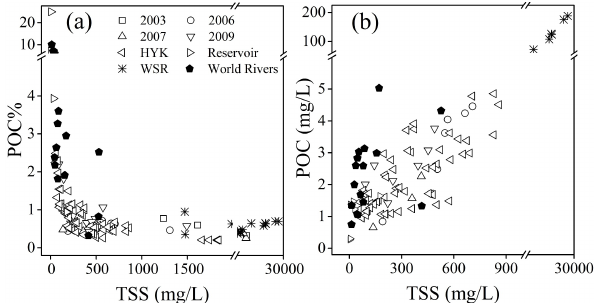
Fig. 5. Relationship between POC% and TSS (a) , and POC and TSS (b) of the Yellow River and world rivers (Ludwig et al., 1996; 2003, 2006, 2007, 2009 indicate the field investigation time along the Yellow River mainstream, respectively; HYK denotes a 1yr ob- servation at the Huayuankou station between November 2005 and November 2006; WSR indicates the entire water and sediment reg- ulation period in 2008 at the Lijin